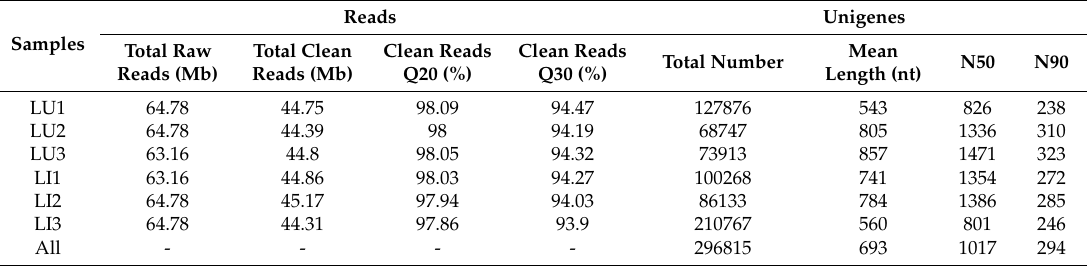
Table 1. Statistics of sequenced data and assembly results. Total RNA was analyzed from the top leaf samples of upright (LU) and inverted (LI) cuttings of P. yunnanensis.